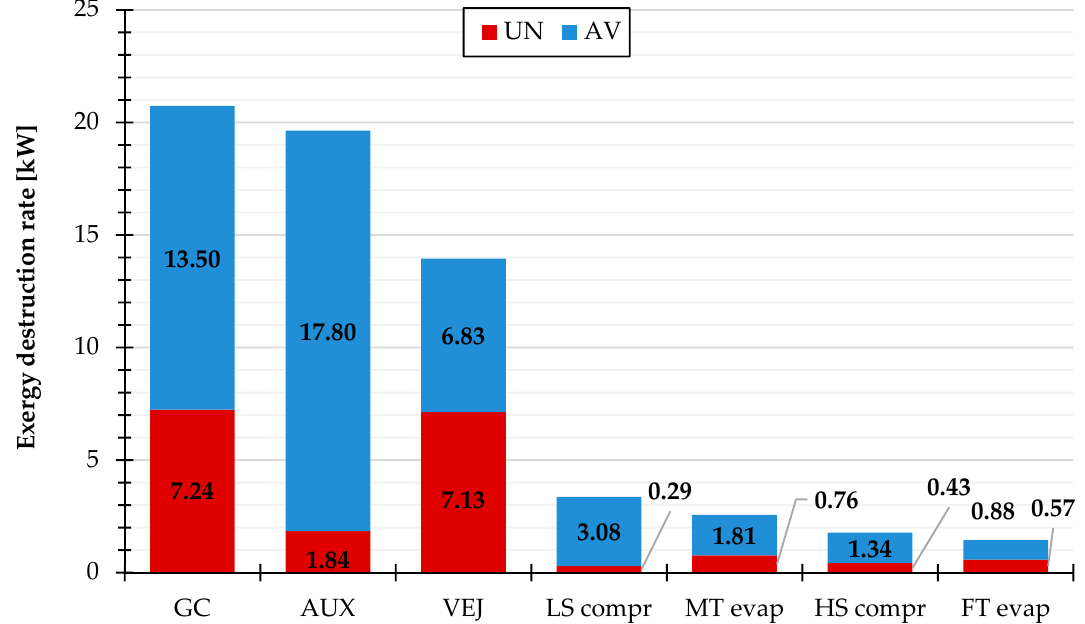
Figure 8. Avoidable and unavoidable exergy destruction rates of some selected components belonging to the proposed enhanced system (EJ) at the outdoor temperature of 40 °C.